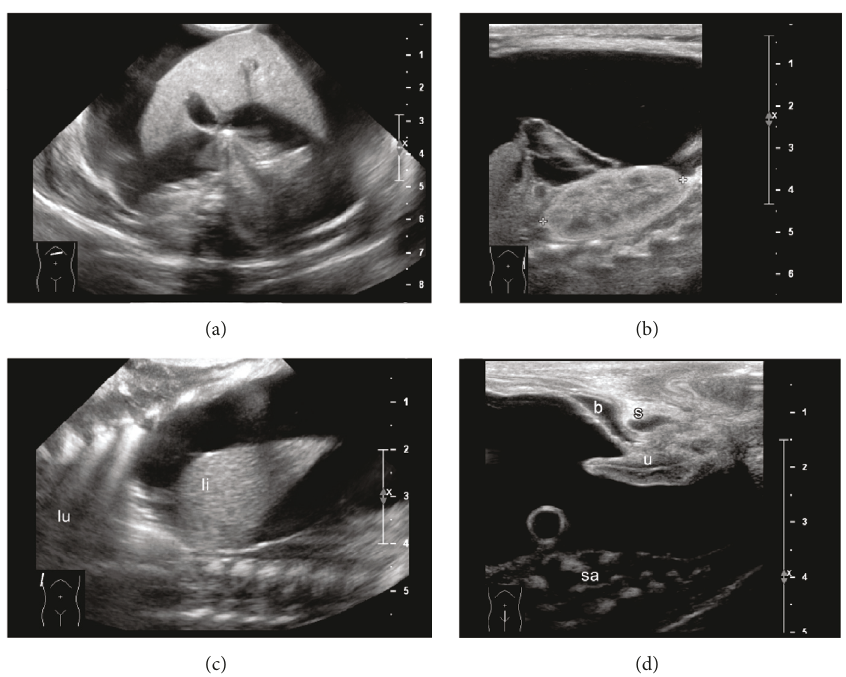
Figure 1: Abdominal ultrasound images showing massive ascites. (a) Transverse section through the epigastrium. (b) Longitudinal section through the left kidney that appears normal in shape and length. (c) Longitudinal section through the liver and lung (li: liver; lu: lung) showing no pleural effusion. (d) Longitudinal section through the bladder (b: bladder; u: uterus; sa: sacrum; s: symphysis), which is almost empty.